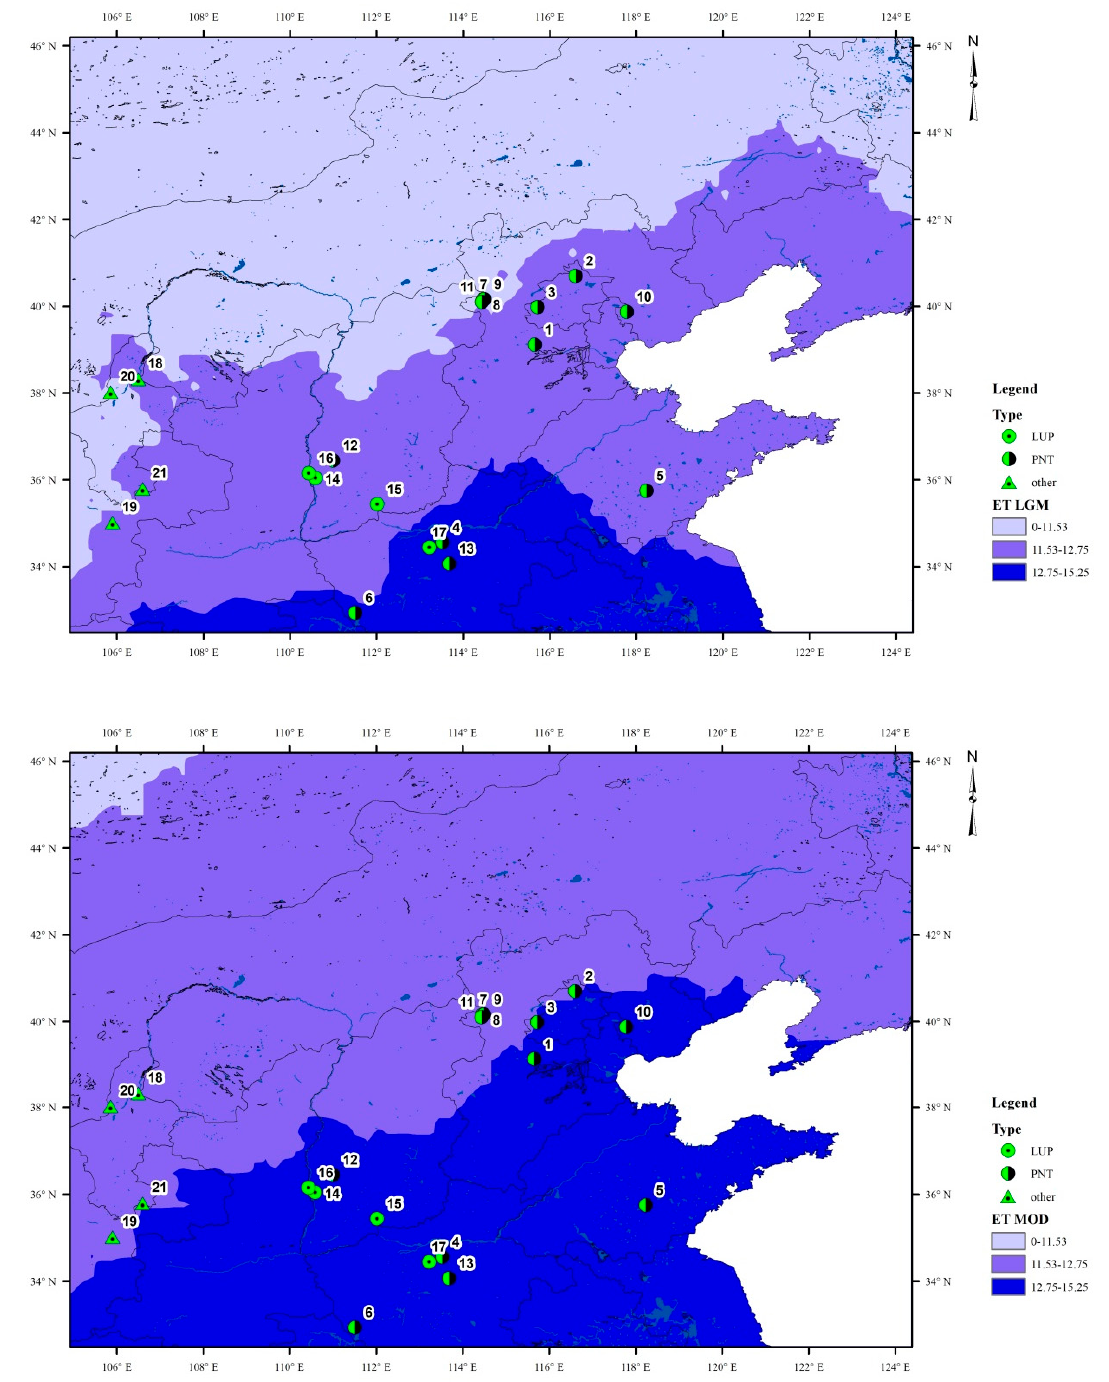
Figure 2. Archaeological sites dated to the Pleistocene to Holocene transition on the maps of effective temperature (ET) in Northern China under LGM and modern climatic conditions.